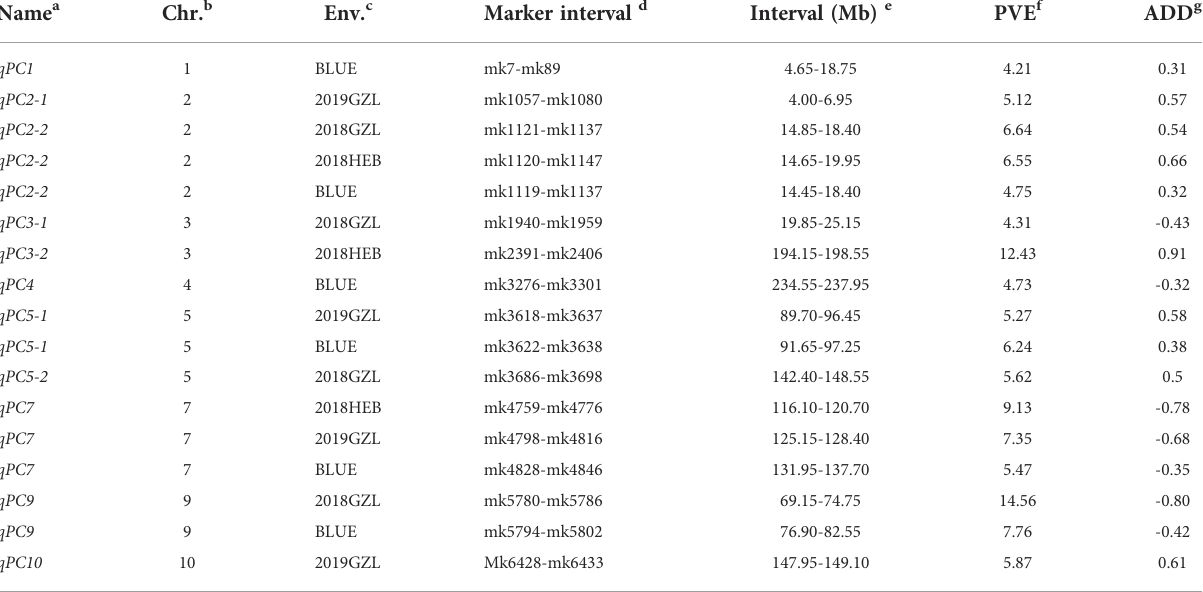
TABLE 3 QTLs detected for kernel protein content in the